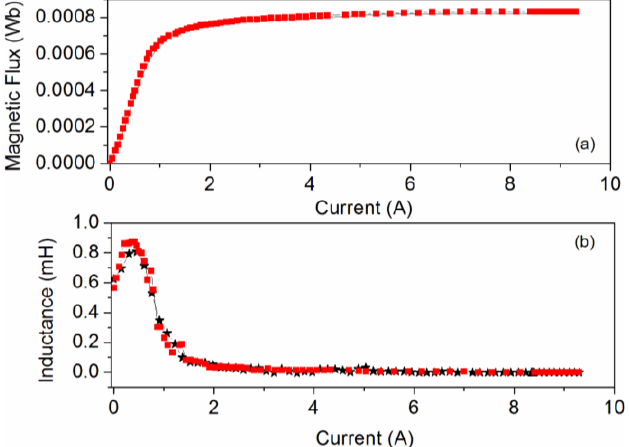
Figure 6. ( a ) Magnetic flux curves. ( b ) L-I curves. Experiment (    ) and 2D simulations (   